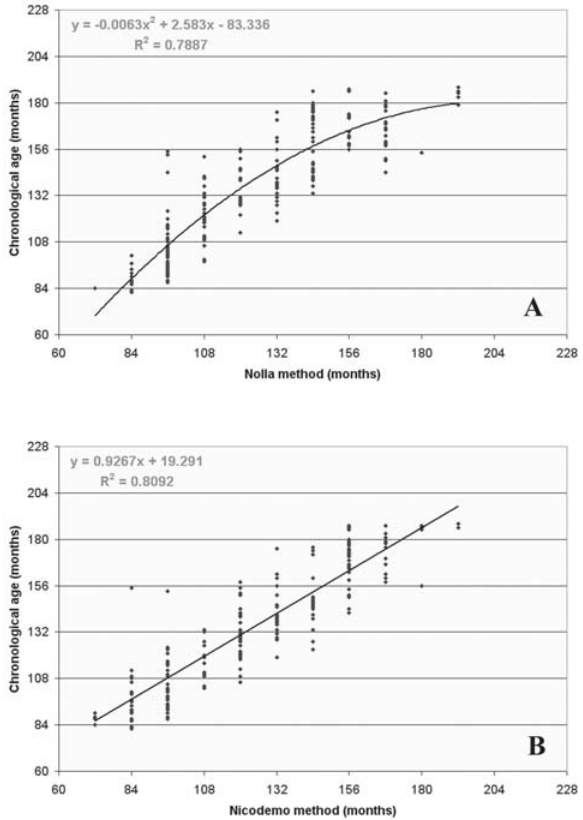
FIGURE 2- Scatter plots and straight line and curves adjusted for regression equations between estimated dental age (X) and chronological age (Y) obtained by both methods for Brazilian boys. A: Nolla method; B: Nicodemo’s, et al. method.